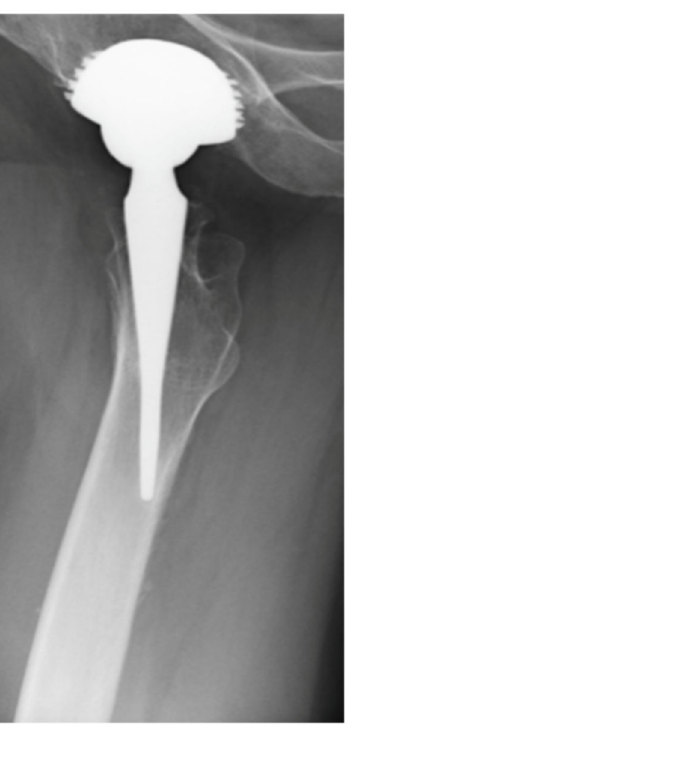
Figure 1. Lateral view of the METHA short stem total hip arthroplasty (STHA), showing the striven positioning parallel to the femoral neck and thus reconstructing the physiological ante torsion of the femoral